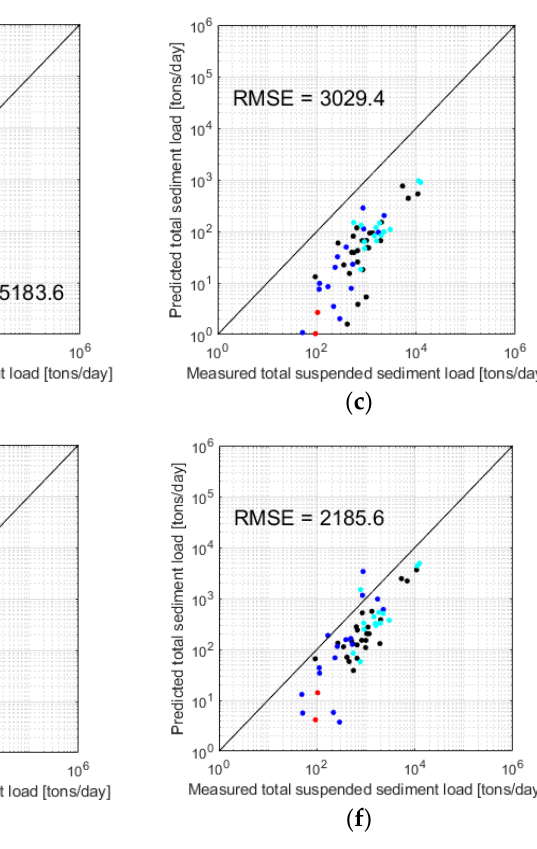
Figure 8. Predicted total sediment loads from models ( a ) M3, ( b ) M4, ( c ) M5, ( d ) M6, ( e ) M7, and ( f ) M8. The black circles represent total sediment load for Geumho River, red circles represent total sediment load for down stream of Hwang River confluence, blue circles represent total sediment load for upstream of Hwang River confluence, and the cyan circles represent total sediment load for Nam River. (In this figure, the measured total suspended sediment load is assumed to be the measured total sediment load).